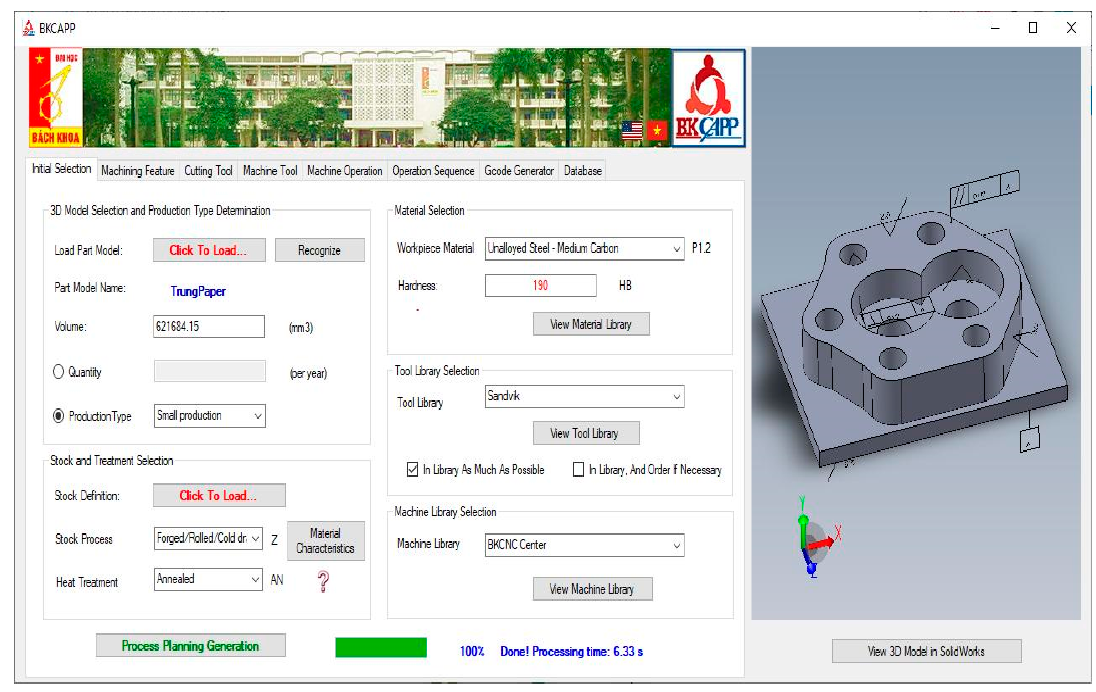
Figure 6. Interface of the BKCAPP system with three-dimensional (3D) part drawing input.